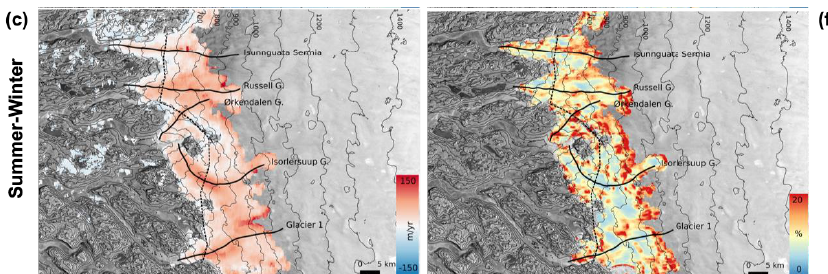
Figure 1. Average ice velocity in ( a ) summer (May–Jul), ( b ) winter (Aug–Apr), and ( c ) the difference between summer and winter, derived from Sentinel-1 (S1) synthetic aperture radar (SAR) imagery. The uncertainties in the maps associated with the summer, winter, and difference between the summer and winter ice speeds are also shown ( d – f , respectively). Velocities and the uncertainties are overlaid on a SAR backscatter intensity image. Also shown are elevation contours (thin grey lines), profiles along (solid black lines) and across (dotted black lines) the centre of five glaciers. The location of the KAN_L weather station is also mapped (red dot, a ).